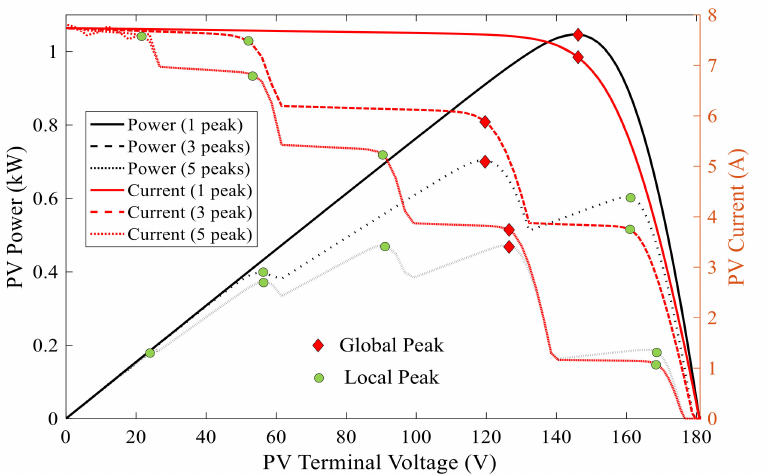
Figure 2. The I - V and P–V characteristics of 5 PV modules in